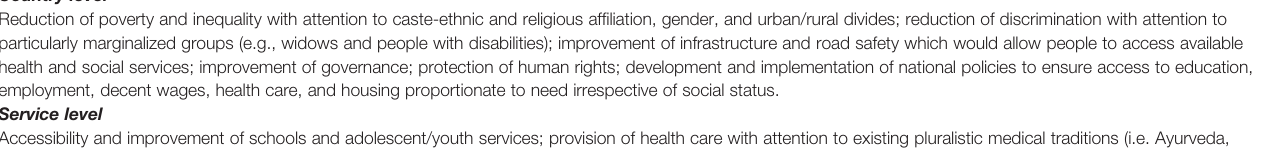
TABLE 2 | Levels and targets of interventions to improve mental health of survivors of war in Dang district, Nepal (Adapted from 16). Country level Reduction of poverty and inequality with attention to caste-ethnic and religious af fi liation, gender, and urban/rural divides; reduction of discrimination with attention to particularly marginalized groups (e.g., widows and people with disabilities); improvement of infrastructure and road safety which would allow people to access available health and social services; improvement of governance; protection of human rights; development and implementation of national policies to ensure access to education, employment, decent wages, health care, and housing proportionate to need irrespective of social status. Service level Accessibility and improvement of schools and adolescent/youth services; provision of health care with attention to existing pluralistic medical traditions (i.e. Ayurveda, Tibetan medicine, ritual or faith-based healing, astrology, herbal medicine, homeopathy and biomedicine); provision of specialized services for survivors of torture and gender-based violence; development and delivery of social and welfare services; creation of a referral system connecting medical, psychosocial and social services; provision of clean water and sanitation. Community level Creation of an information system enabling access to health and social services; building of neighbourhood trust/cohesion and safety; carrying out community-needs assessments; respect for places for spiritual/religious healing and communal practice/worship/celebration; enabling of community involvement and participation with attention to local power dynamics related to socioeconomic status, caste-ethnic and religious af fi liation, age, gender, and disability; creation and implementation of support groups for survivors of violence and loss; prevention of violence/crime; reduction of social and economic deprivation at the neighbourhood level. Household and working life level Support for families and strengthening support within and across extended families with attention to loss of family members during the con fl ict and change in social position of female members, esp. daughters-in-law and widows; improvement of material conditions (i.e., income, access to resources to ful fi l basic needs); improvement of employment conditions and decrease in unemployment (with attention to agriculture); provision of decedent wages; provision of pregnancy and maternal health care and social support. Life course level Health and social support provision during prenatal, pregnancy and perinatal periods; early childhood; adolescence; working and family building years; and older age, all with attention to social position and